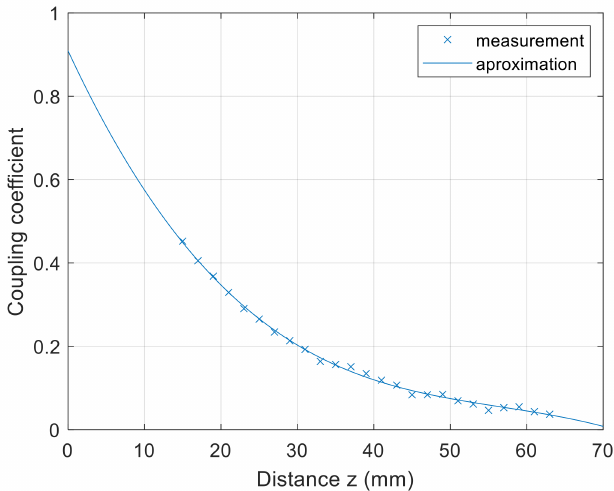
Figure 13. z -axis coupling coefficient measurement of planar DD